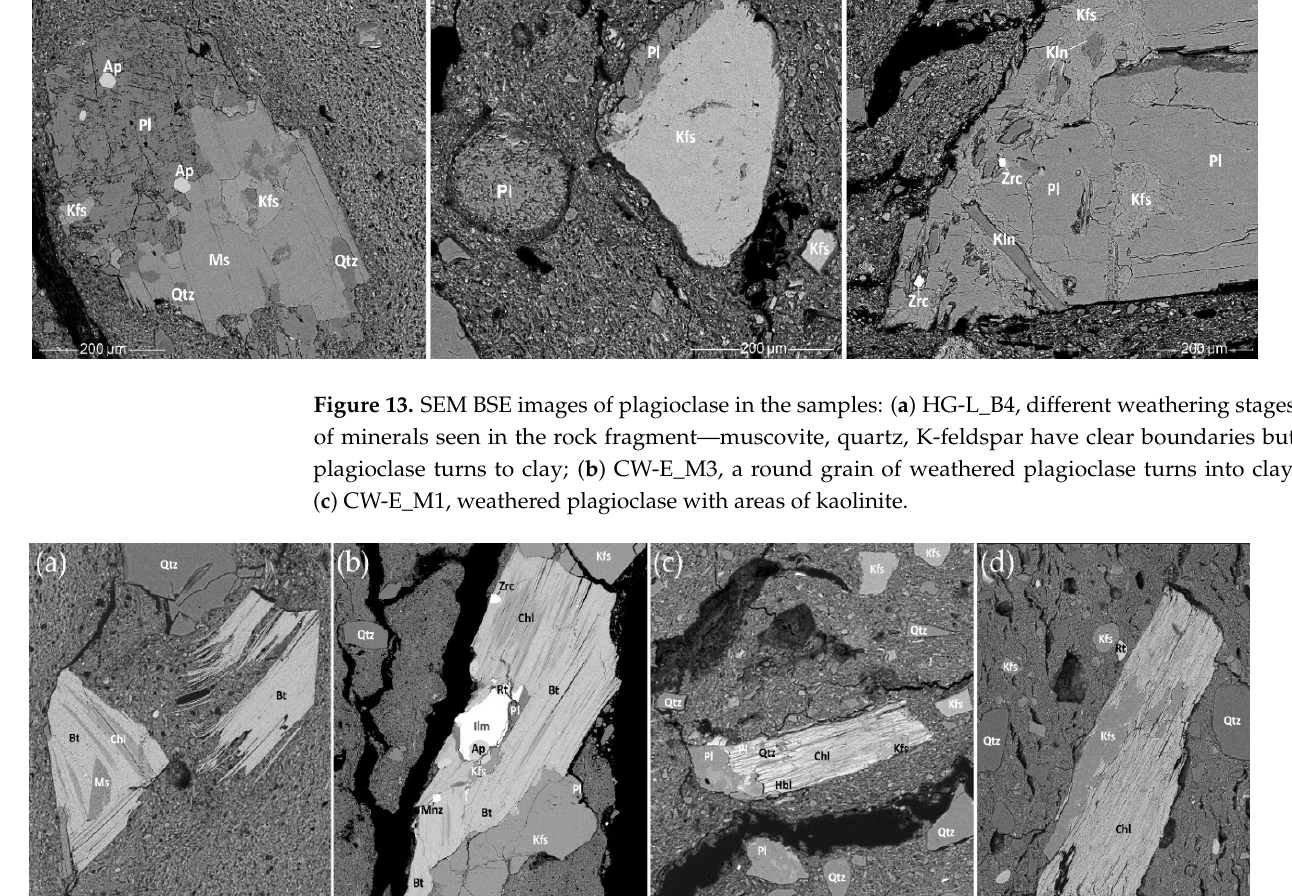
Figure 13. SEM BSE images of plagioclase in the samples: ( a ) HG-L_B4, different weathering stages of minerals seen in the rock fragment—muscovite, quartz, K-feldspar have clear boundaries but plagioclase turns to clay; ( b ) CW-E_M3, a round grain of weathered plagioclase turns into clay; ( c ) CW-E_M1, weathered plagioclase with areas of kaolinite.